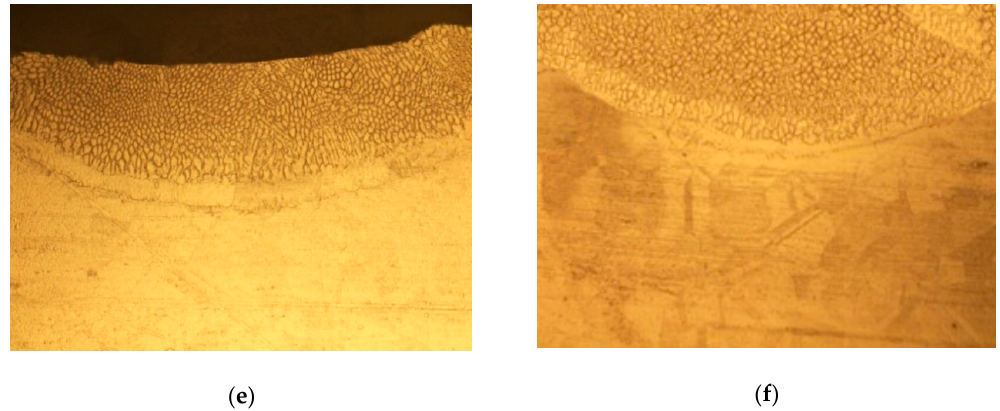
Figure 8. ( a ) Optical micrographs of the parent austenitic stainless steel 316. Formed samples at D b and h s of ( b ) 0.25 and 1.0; ( c ) 0.5 and 0.5; ( d ) 0.7 and 0.5; ( e ) 1.0 and 0.5; and ( f ) 1.3 and 0.5 mm, respectively.